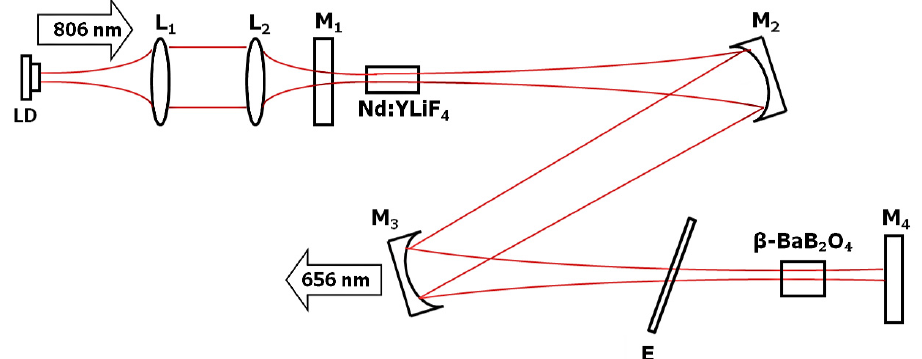
Fig. 1. (Color online) Setup of the cw-diode pumped Nd:YLiF 4 / β -BaB 2 O 4 for the generation of single frequency radiation at λ 2 ω = 656 nm. LD: Laser Diode, L 1 : Lens, L 2 : Lens, M 1 : Mirror (HT 806 nm, HR 1312 nm), M 2 : Mirror (HR 1312 nm), M 3 : Mirror (HT 656 nm, HR 1312 nm), M 4 : Mirror (HT 656 nm, HR 1312